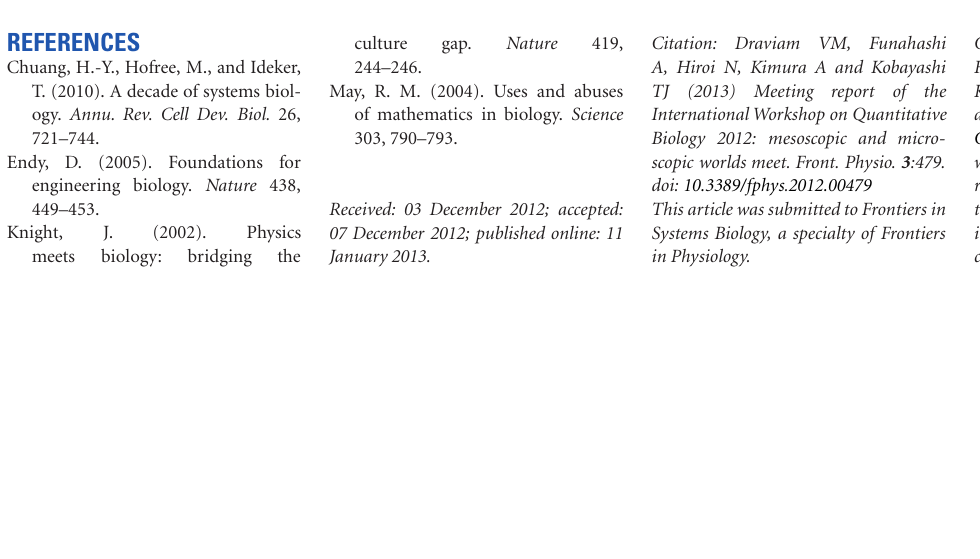
in chromosome-microtubule attachment by Prof.